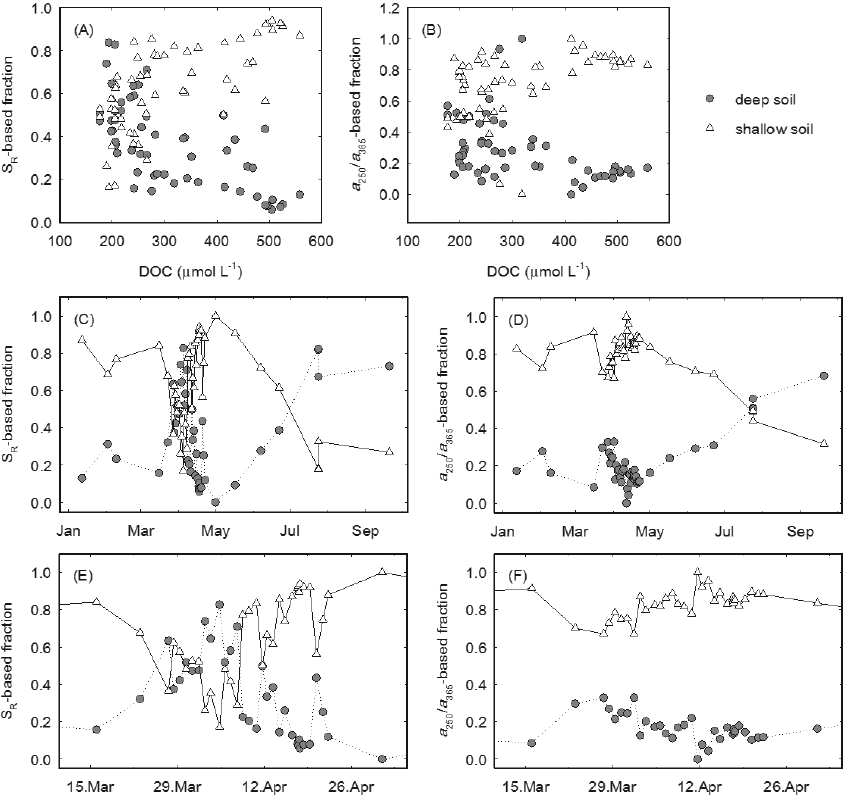
Figure 8. The contributions of deep and shallow soil DOC to total Fraser DOC were estimated based on the observed maximum and minimum values of DOC optical properties (spectral slope ratio, S R , and absorbance ratio, a 250 /a 365 ) . These fractions are related to the DOC concentration ( a and b ), and change throughout the year ( c and d , shown here for 2013; e and f detail the 2013 early freshet period).